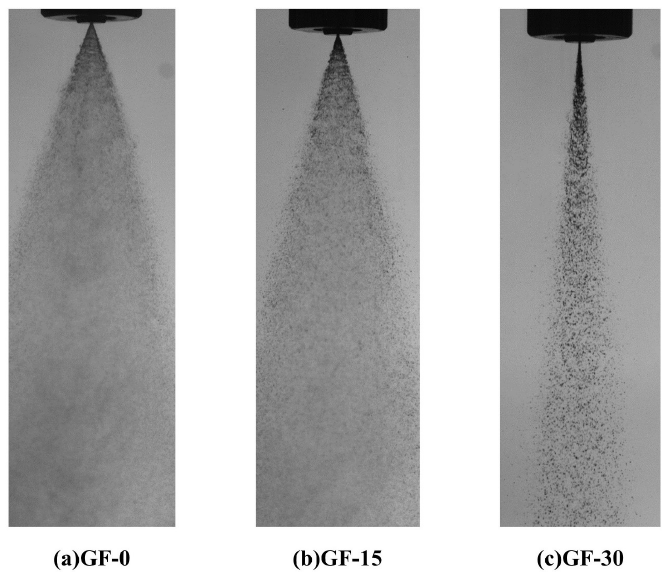
Figure 7. Spray images of different gelled fuels using swirl nozzles.